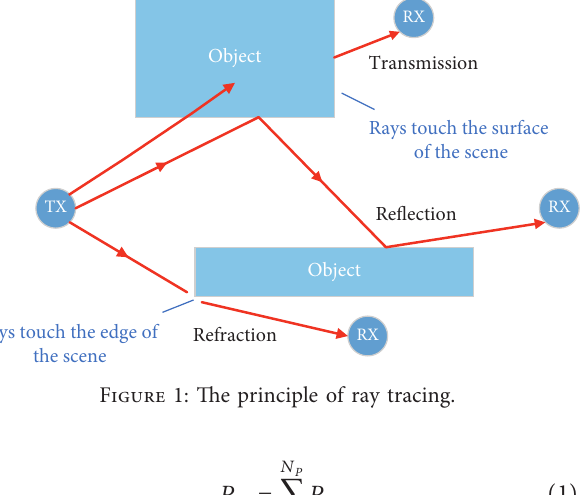
Figure 1: The principle of ray